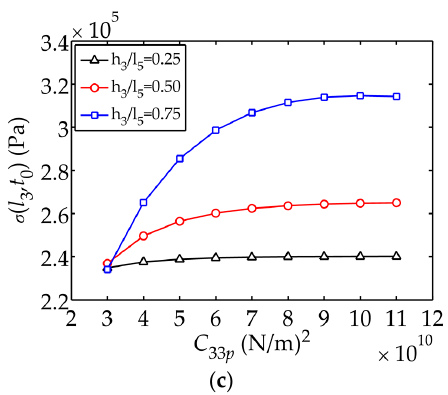
Figure 6. Displacement w c ( l 5 , (cid:1872) (cid:2868) ), electric potential ϕ ( l 3 , (cid:1872) (cid:2868) ) and stress (cid:2026) (cid:3030) ( l (cid:2869) , (cid:1872) (cid:2868) ) changing with C 33p : ( a ) Displacement w c ( l 5 , (cid:1872) (cid:2868) ); ( b ) Electric potential ϕ ( l 3 , (cid:1872) (cid:2868) ); ( c ) Stress (cid:2026) (cid:3030) ( l 1 , (cid:1872) (cid:2868) ).